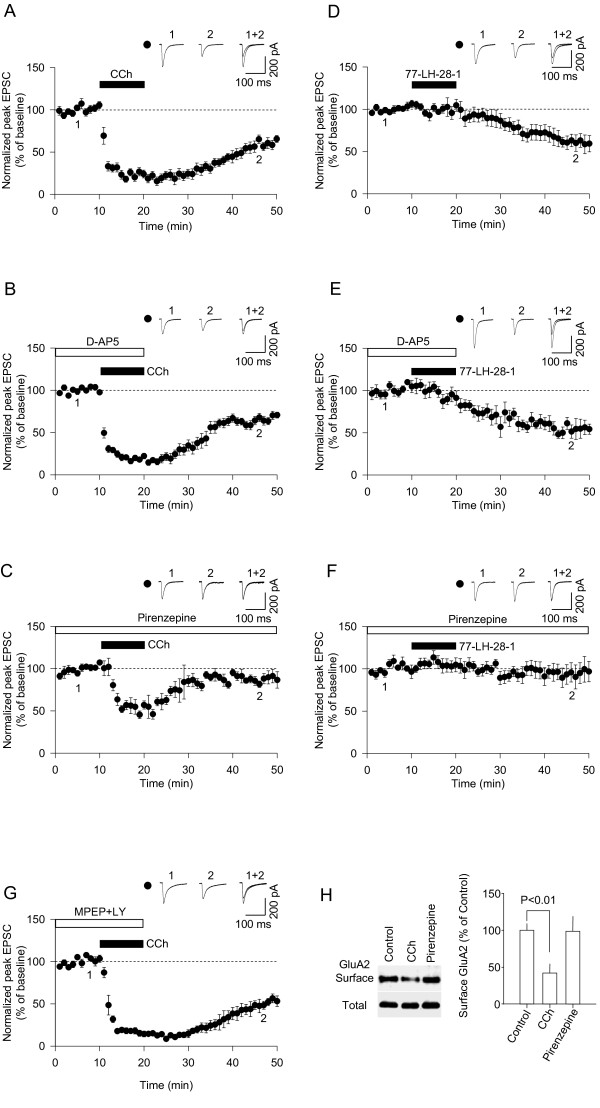
Properties of CCh-induced LTD in the CA1 region of the hippocampus. (A) A pooled data (n = 8) of EPSC amplitude vs time to show that carbachol application (CCh, 50 μM, 10 min) induces mAChR-LTD. (B) D-AP5 (50 μM) has no effect on mAChR-LTD (n = 9). (C) mAChR-LTD was prevented by bath application of an M1 mAChR antagonist, pirenzepine (0.5 μM, n = 5). (D) The M1 specific agonist, 77-LH-28-1, induces LTD (n = 6). (E) D-AP5 (50 μM) has no effect on LTD induced by 77-LH-28-1 (n = 5). (F) Pirenzepine (0.5 μM) prevents LTD induced by 77-LH-28-1 (n = 7). (G) Co-application of LY367385 (100 μM) and MPEP (50 μM) has no effect on mAChR-LTD (n = 6). (H) An example of biotinylation from hippocampal slices. Pooled data (n = 4) shows that CCh induces internalisation of GluA2. Error bars represent s.e.m.